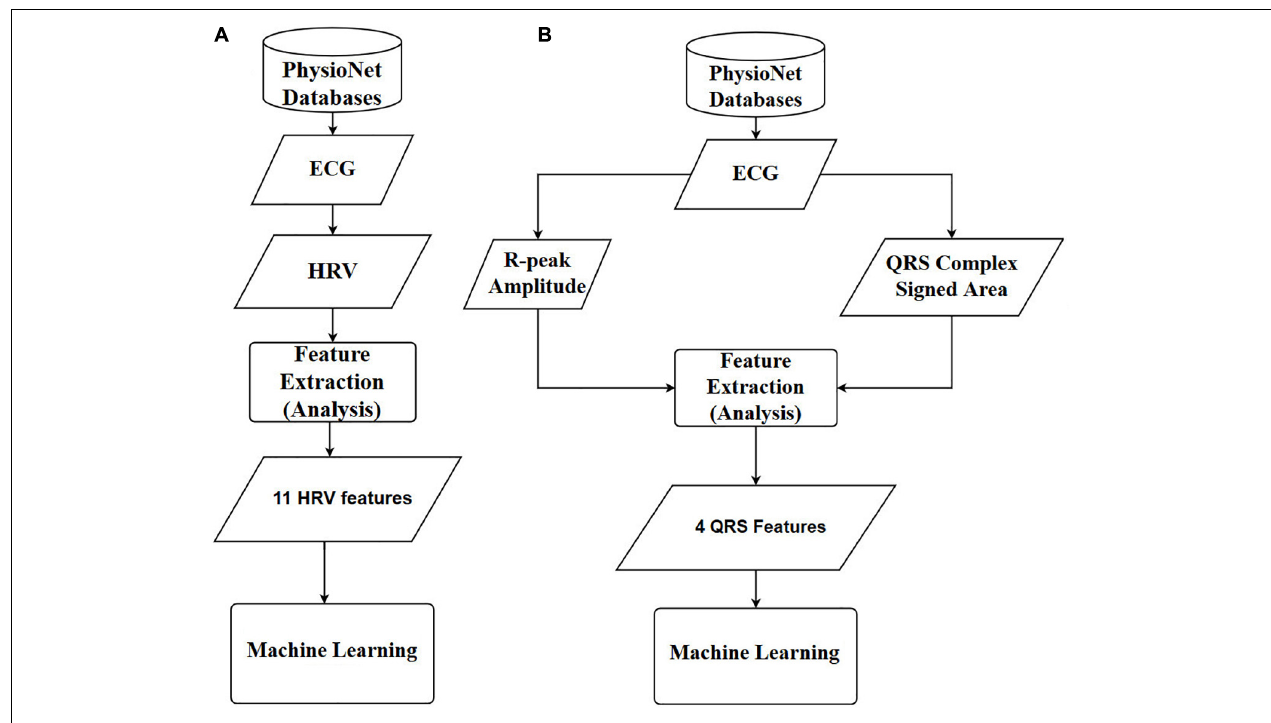
FIGURE 4 | Overall diagrams of the proposed approach for early prediction of VF. (A) Using 11 HRV features. (B) Using 4 QRS complex features. ECG: electrocardiography, HRV: heart rate variability, ANN: artificial neural network. TABLE 2 | Comparison of HRV and QRS complex shape features between control and VF dataset (see Supplementary Material for more illustration). Features VFs dataset Control dataset p